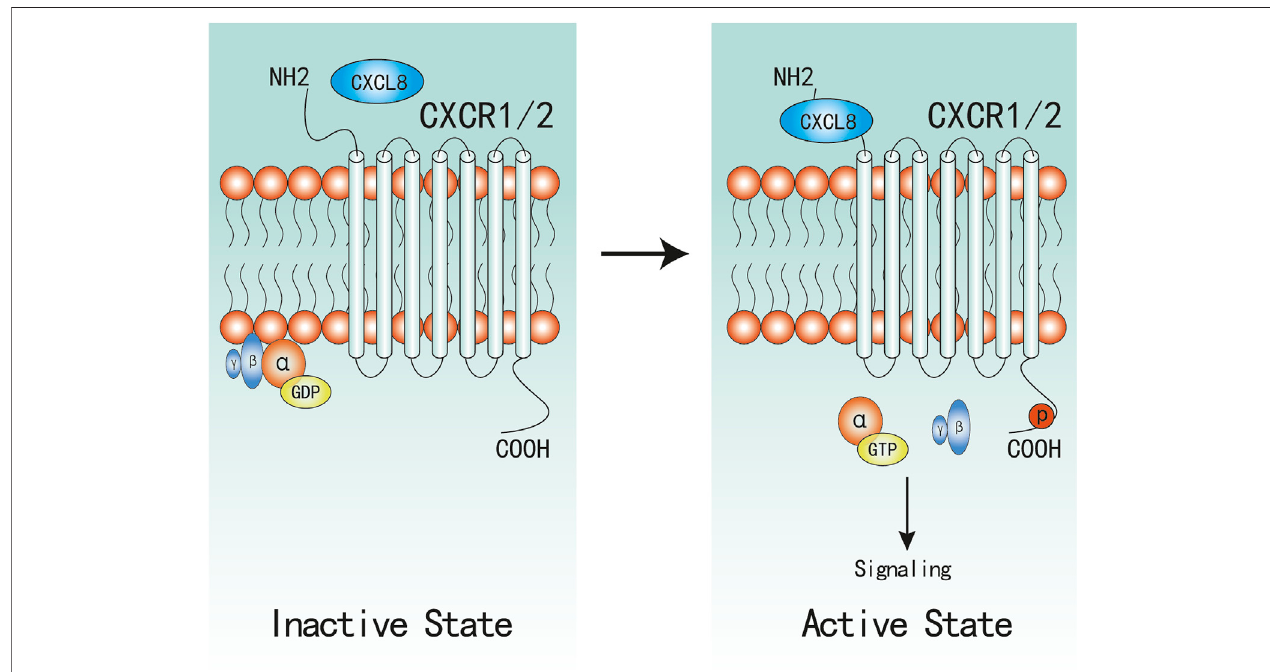
FIGURE 1 | Active and Inactive Structures of CXCR1/2 Complex. CXCR1/2 is in complex with G αβγ in inactive state. When CXCL8 binds to the N-terminal of CXCR1/2, α -GDP changes into α -GTP, and dissociates with βγ subunites, which would subsequently active associated signaling.